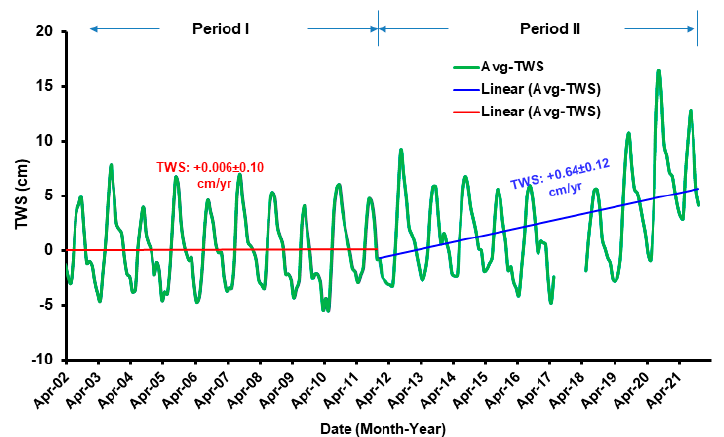
Figure 7. Monthly time series of the Δ TWS over Chad using the three mascon solutions and their mean.